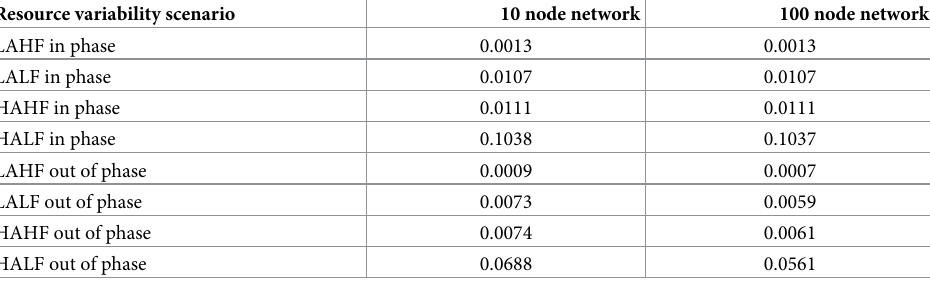
Table 3. The coefficient of variation of the Global Equilibrium Population (GEP, the average population of the nodes in the networks after equilibrium) over time in the different networks and the climate variability scenarios: Low amplitude high frequency (LAHF), low amplitude low frequency (LALF), high amplitude high frequency (HAHF) and high amplitude low frequency (HALF). GEP is more stable over time in out of phase scenario’s and within the variability scenarios more stable in higher frequency and lower amplitude of